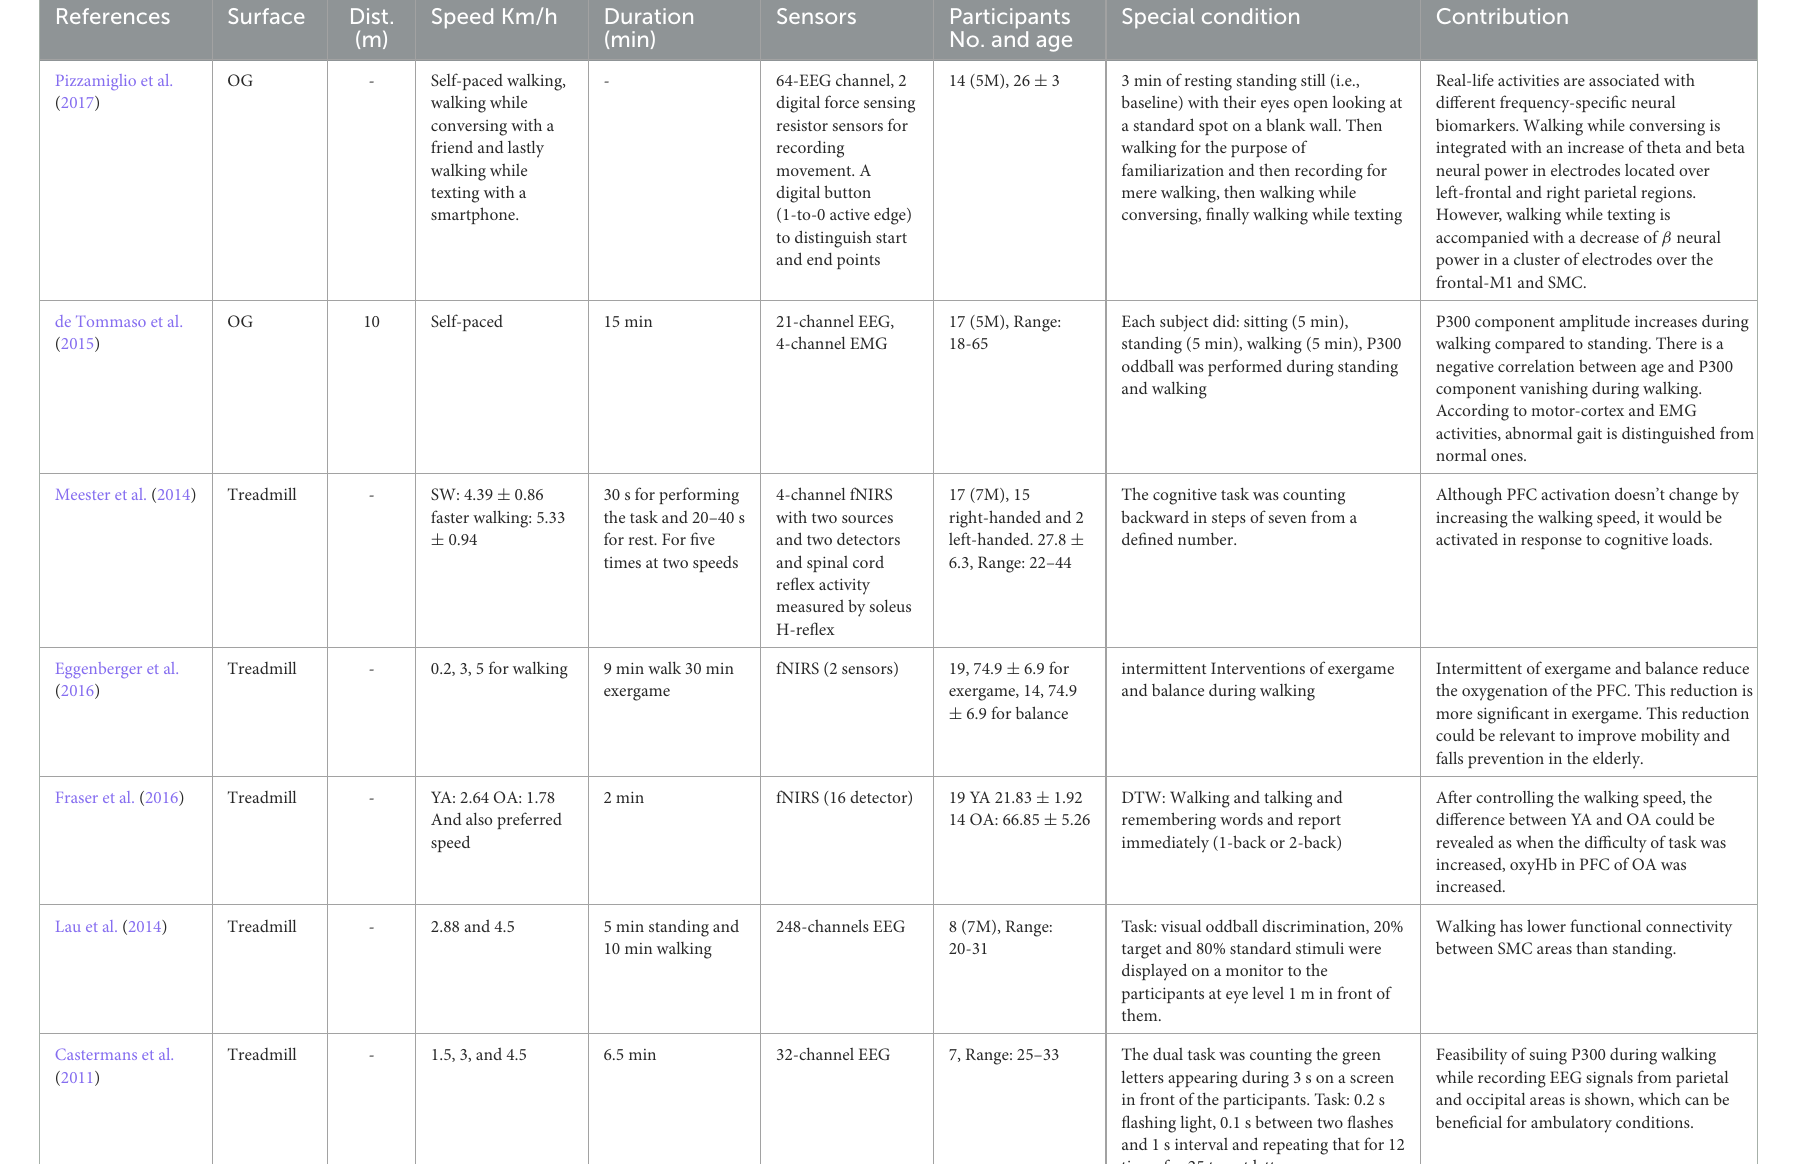
Task: visual oddball discrimination, 20% target and 80% standard stimuli were displayed on a monitor to the participants at eye level 1 m in front of them. The dual task was counting the green letters appearing during 3 s on a screen in front of the participants. Task: 0.2 s flashing light, 0.1 s between two flashes and 1 s interval and repeating that for 12 times for 25 target